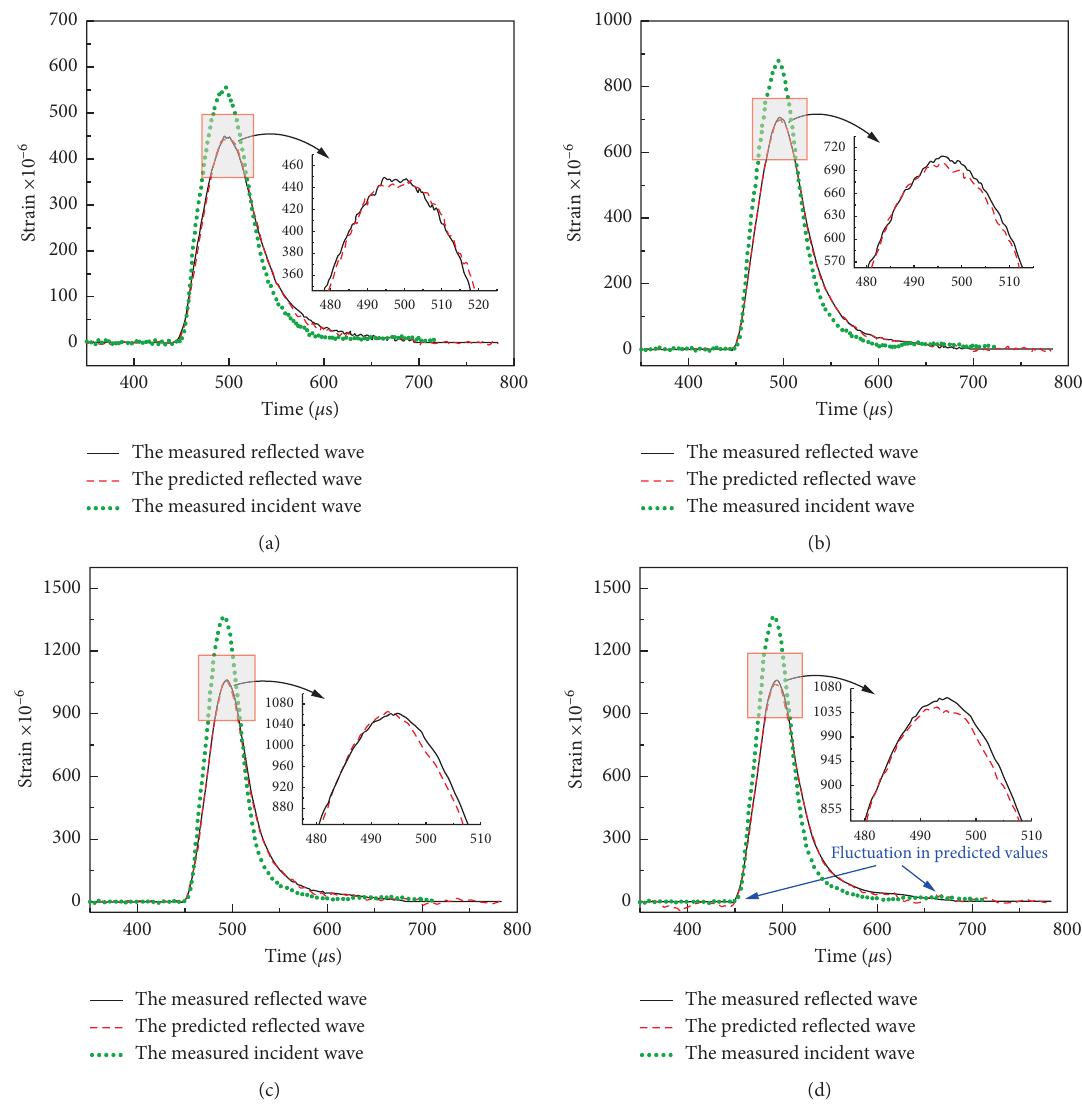
Figure 8: Waveform prediction results. (a) A � 5.10 m/s, B � 7.77 m/s. (b) A � 5.10 m/s, B � 12.27 m/s. (c) A � 5.10 m/s, B � 19.10 m/s. (d) A � 12.27 m/s, B � 19.10